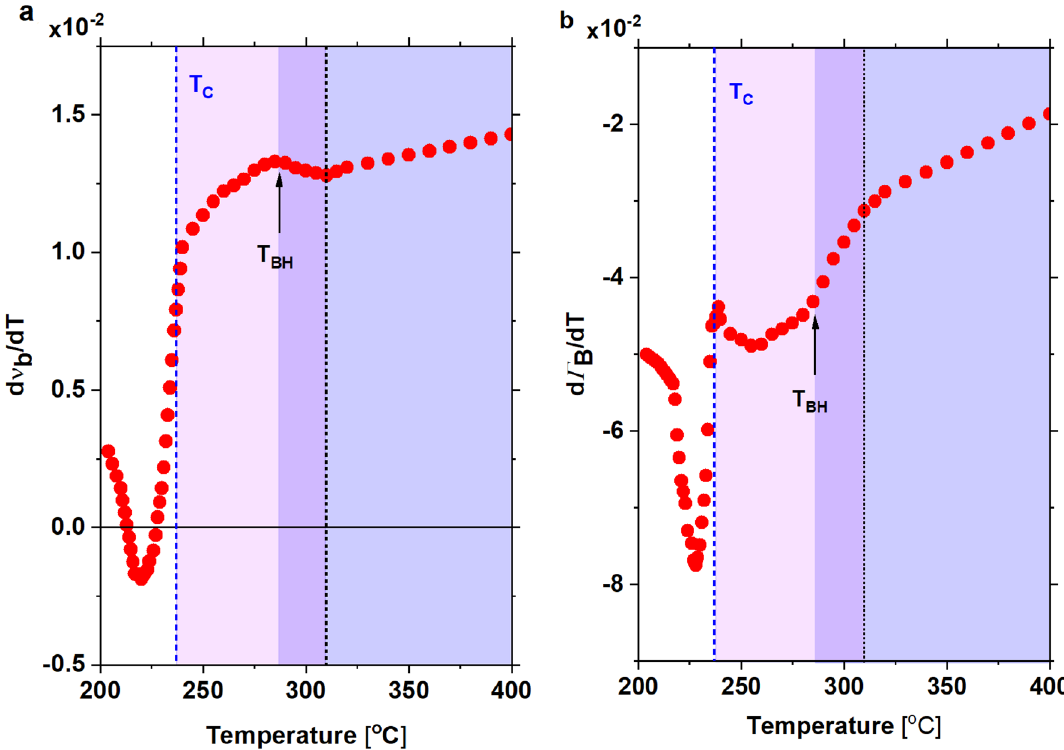
Figure 4. The first derivative of ( a ) frequency and ( b ) damping of the LA1 mode in PZO:Nb single crystal. Temperature changes of its frequency and damping coefficient above T C reflect the temperature changes in the strength and damping of the central peak (CP) observed by Raman light scattering 10 . Anomalies of these values are visible at 310 °C and T BH . Also, the relaxor dumping changes between T BH and T C , as reported in 10 , are divided in 255 °C into two parts, as the vibration damping of the LA1